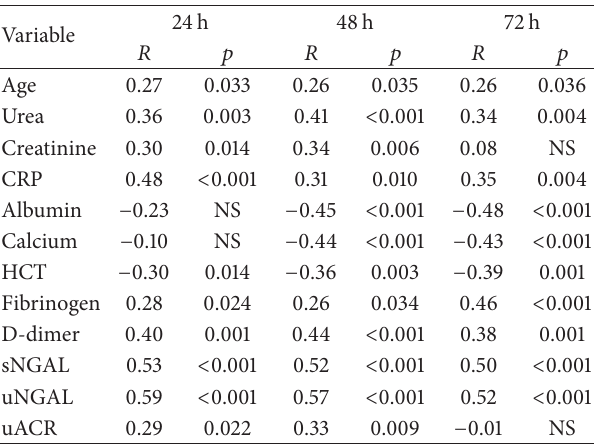
Table 4: Simple correlations between angiopoietin-2 and selected variables during the first 72 hours of acute